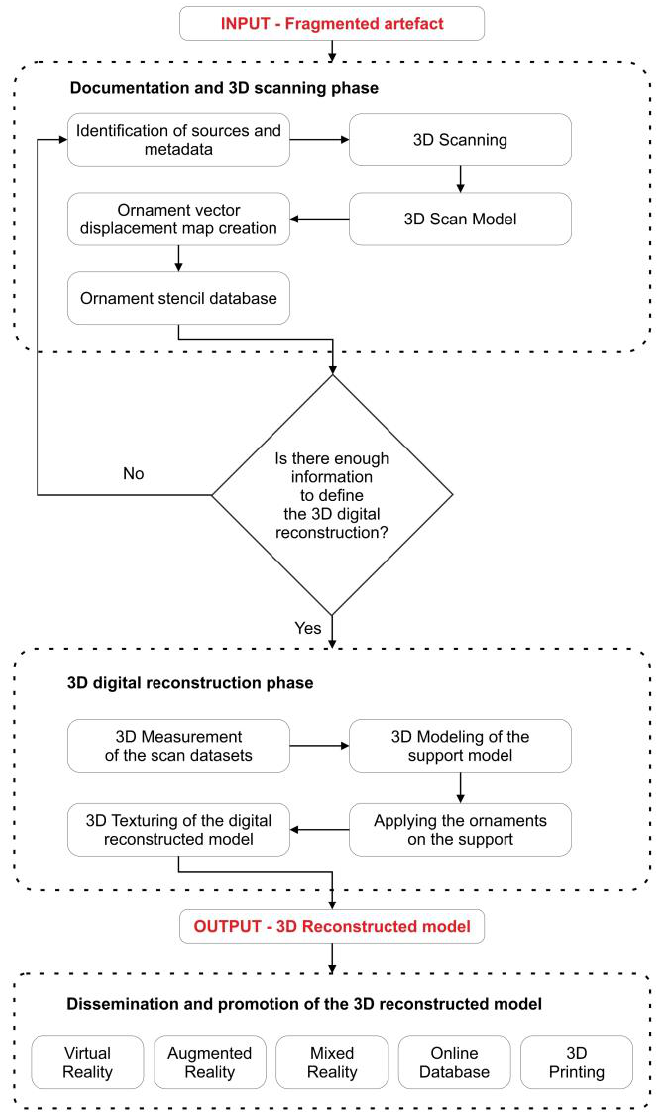
Figure 2. The proposed framework based on ornament vector displacement map creation for the 3D reconstruction, dissemination, and promotion of digitally reconstructed